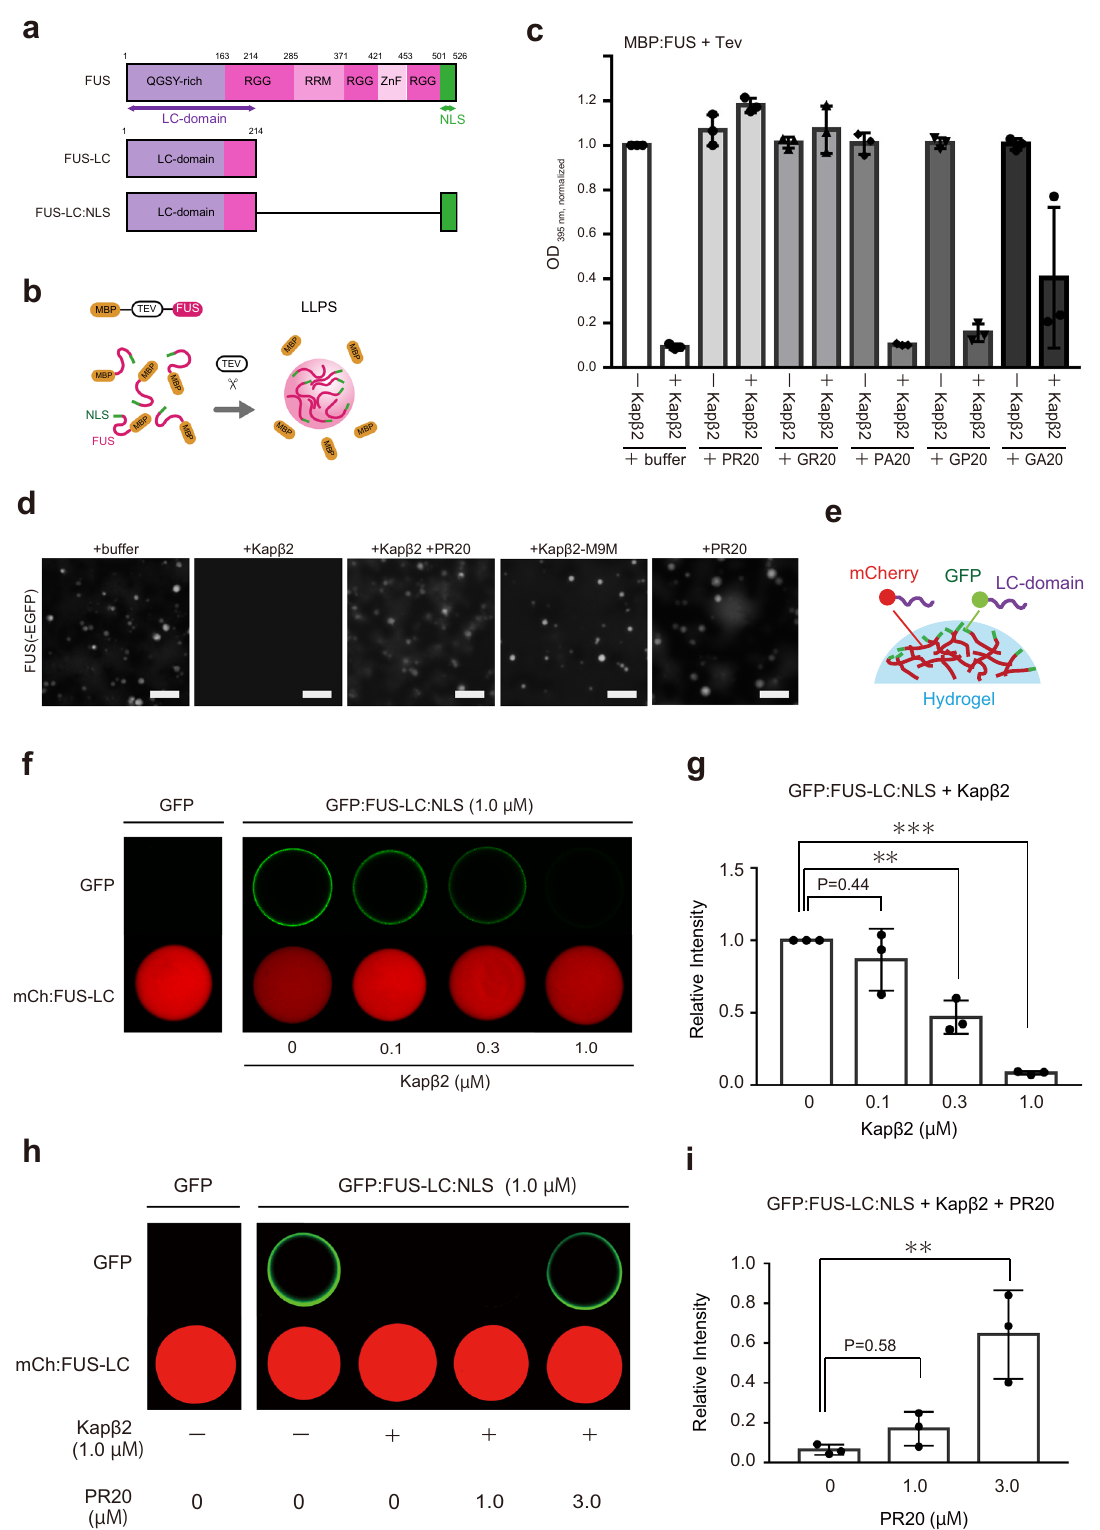
and presence of PR20 (Fig. 3c). The addition of PR20 induced signi fi cant perturbations to several resonances of Kap β 2 (Fig. 3c), indicating that PR poly-dipeptides bind to speci fi c regions of Kap β